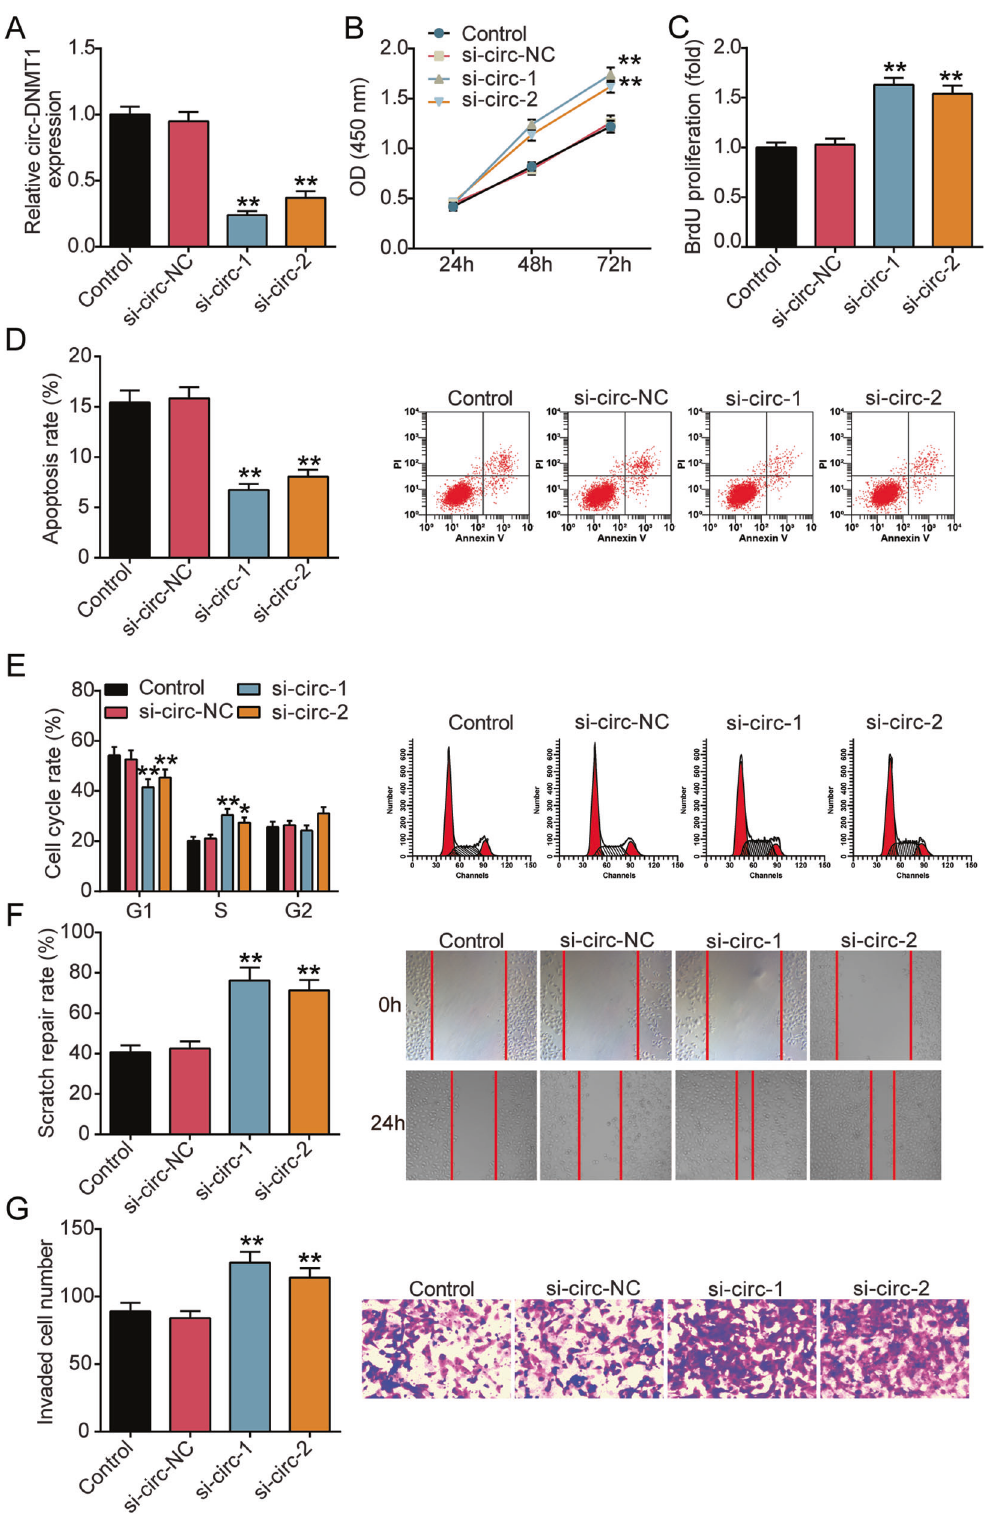
Fig. 2 Silencing circ-DMNT1 promoted trophoblast cell proliferation, migration, and invasion, inhibited apoptosis, and induced cell cycle. A HTR-8/SVneo cells were transiently transfected with circ-DMNT1 siRNA#1 and #2 for 48 h. qRT-PCR analysis knockdown expression of circ-DMNT1. B CCK-8 assays were implemented to detect the viability of si-circ-1/si-circ-2-treated HTR-8/SVneo cells. C BrdU assays were implemented to detect the proliferation of si-circ-1/si-circ-2-treated HTR-8/SVneo cells. D The apoptotic rates of HTR-8/SVne cells transfected with si-circ-1 or si-circ-2 were measured by fl ow cytometry. E The cell cycle of HTR-8/SVne cells transfected with si-circ-1 or si-circ-2 was measured by fl ow cytometry. F Wound scratch assay was performed to detect the role of circ-DMNT1 on si-circ-1 or si-circ-2-treated HTR-8/ SVne cell migration in vitro. G Transwell assays were performed to detect the invasion of HTR-8/SVne cells transfected with si-circ-1 or si-circ-2. * P < 0.05, ** P < 0.001 compared with si-circ-NC. N = 3, repetition = 3. Cell Death Discovery (2022)